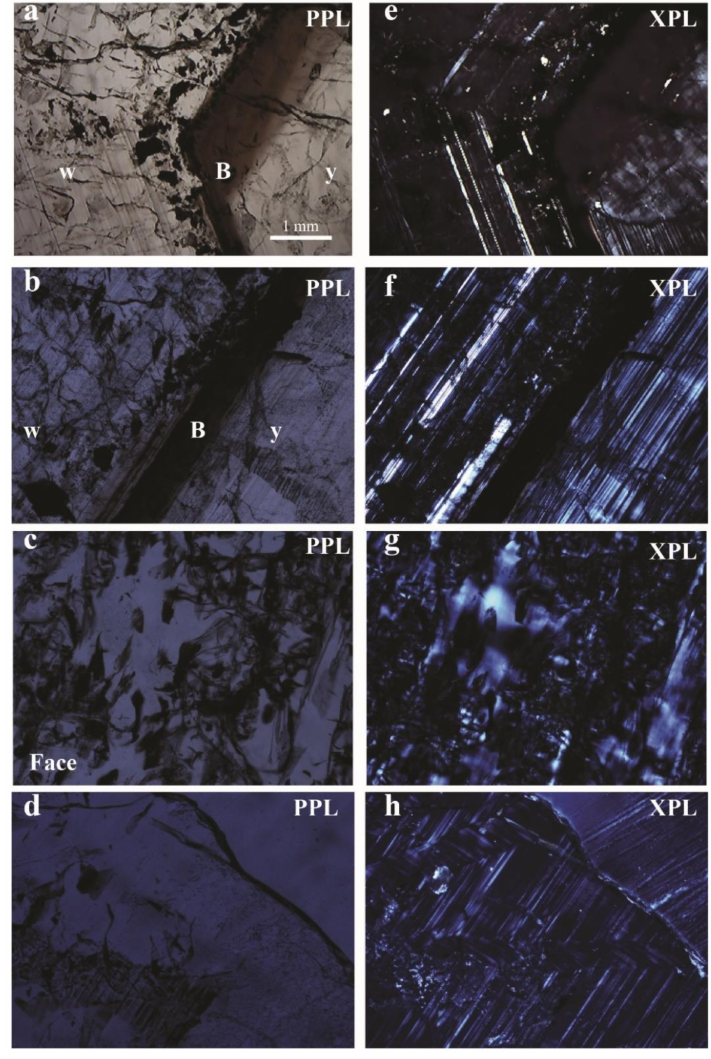
Figure 4. Thin-section images for sample-5 from Chihuahua, Mexico: ( a – d ) are plane-polarized light (PPL) and ( e – h ) are the corresponding cross-polarized light (XPL) images. In ( a , b ), the white rim of the crystal is indicated by w, the yellow core is indicated by y, and the northeast diagonal band is the boundary (B) between w and y. Image ( h ) contains chevron features. Images ( e , f ) contain lamellar features, which may represent different phases. A euhedral face of the crystal ( c , h ) shows some mottling features. Important crystal features are only observed along special directions. The scale bar for all the images are shown in ( a ) and represents 1